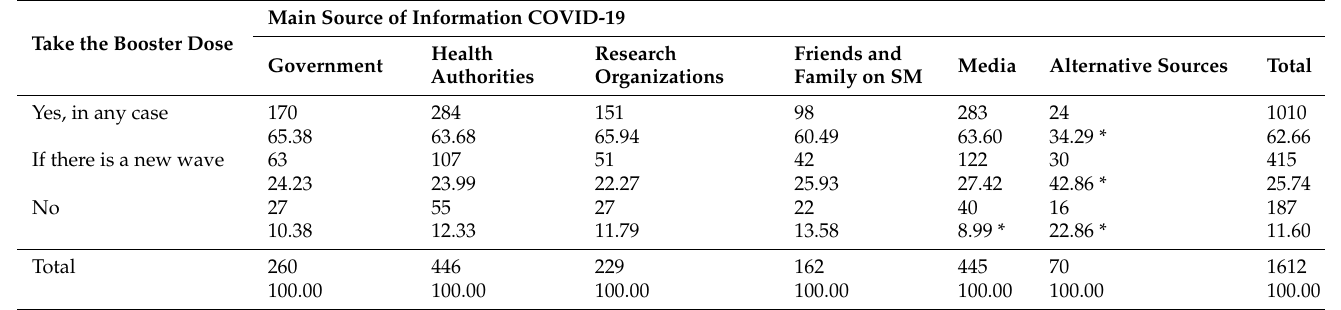
Table 5. Relationship between the intention to vaccinate with the booster dose and the most frequently used sources of